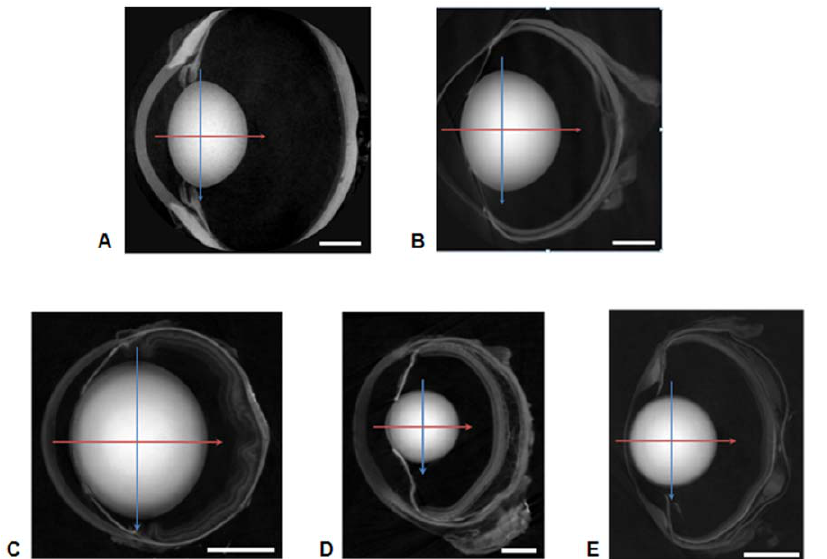
Figure 1. Images of a) porcine; b) ranine; c) murine; d) newt; e) piscine eyes in the sagittal plane. The position of the equatorial plane is marked with the blue arrow and the optic axis, along which the sagittal refractive index profiles were measured, is marked with a red arrow. The scale bars in the right hand lower corner are equal to a) 4 mm (porcine); b) 2 mm (ranine); c) 1 mm (murine); d) 0.5 mm (newt); e) 1 mm (piscine).